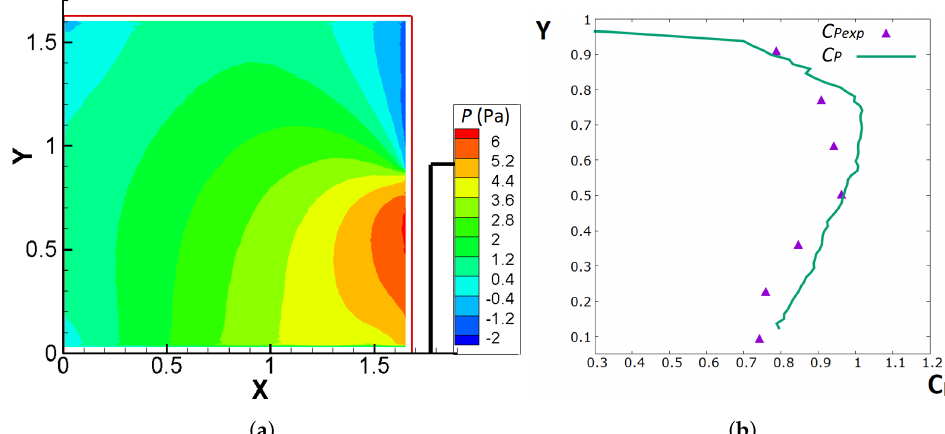
Figure 7. ( a ) Pressure contours, P (Pa), on plane A where the solid boundary of the cube is denoted by the thick black line, while X and Y are non-dimensional coordinates. ( b ) Comparison between C P [45] and calculated C P on the centre line of the upstream wall of the cube, where the Y-axis exp corresponds to the non-dimensional distance from the south boundary of the PIV domain ( Y = 0.91 denotes the upper edge of the cube). Flow is from left to right in ( a ) (Adapted with permission from Ref. [45]).